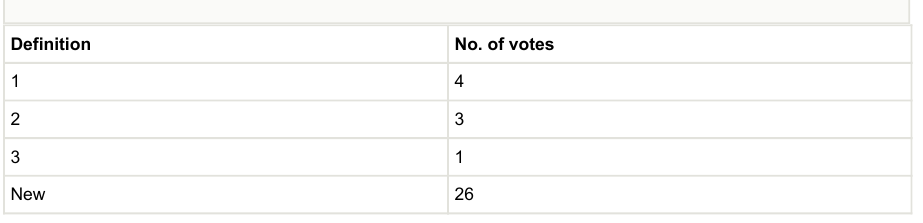
Table 2. Results of the poll to vote for the MAF